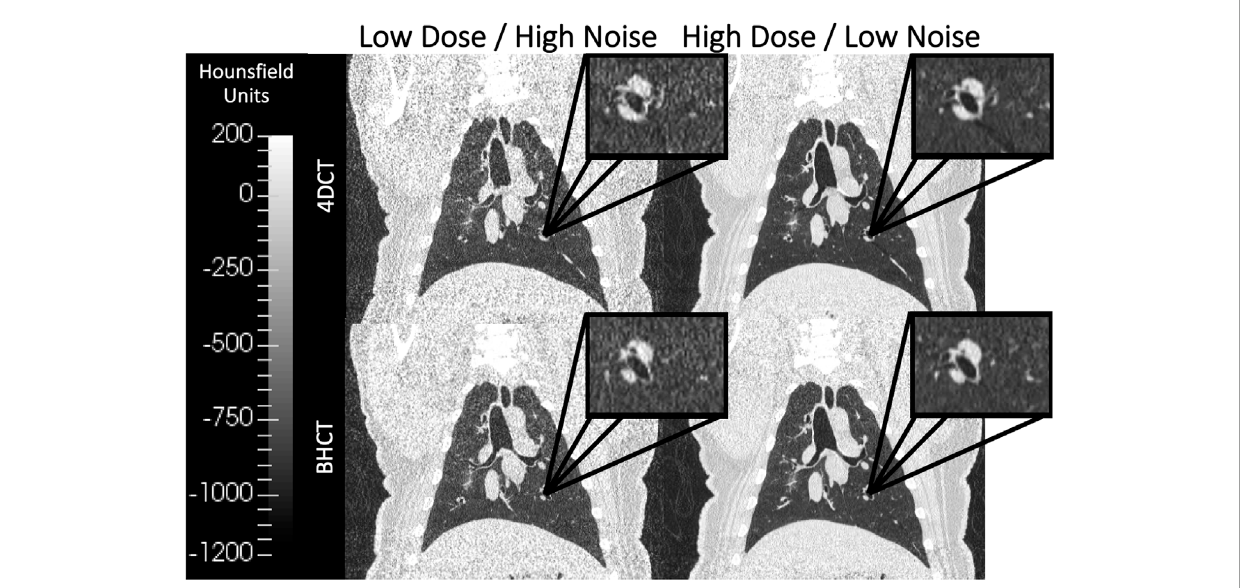
FIGURE 2 Coronal images of scans acquired at multiple dose levels are shown. The top row shows 4DCTs acquired with low dose (CTDI vol = 6.07 mGy) on the left and high dose (CTDI vol = 60.7 mGy) on the right. Similarly, the bottom row shows 4DCTs acquired with low dose (CTDI vol = 1.3 mGy) on the left and high dose (CTDI vol = 7.9 mGy) on the right. Qualitatively, the lower dose images in the left column show increased image noise relative to the high dose images of the right column. All four displayed images were reconstructed without IR applied.